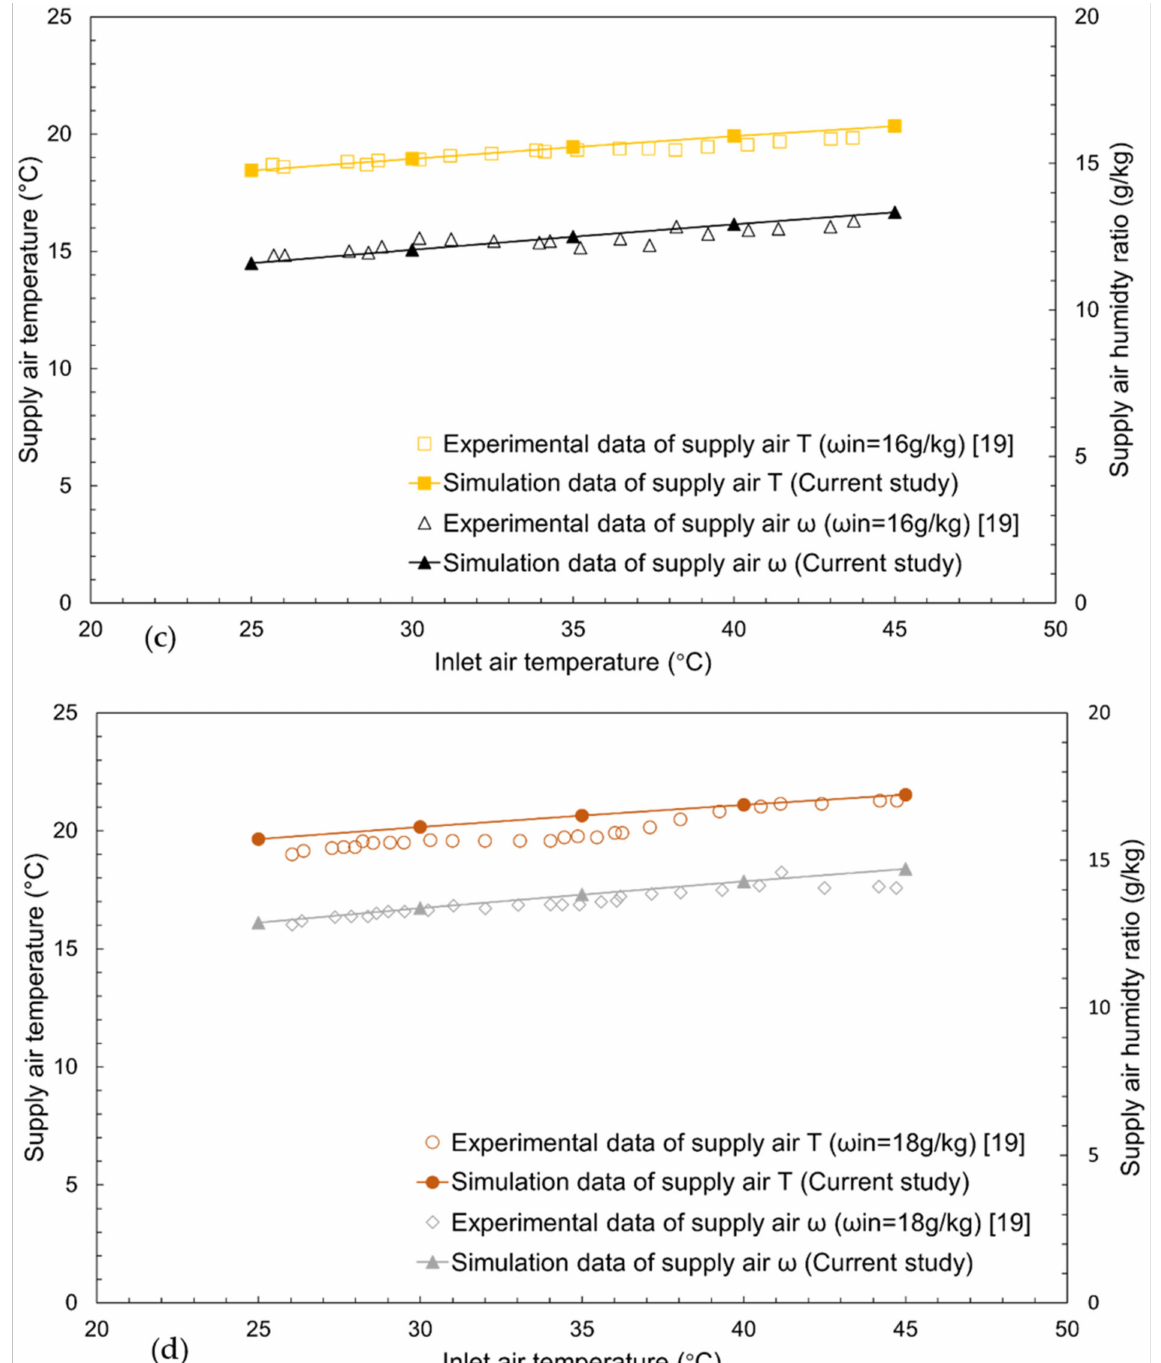
Figure 3. SDM model verification with experimental data from Ref. [18] at four different inlet air humidity levels: ( a ) ω in = 12 g/kg; ( b ) ω in = 14 g/kg; ( c ) ω in = 16 g/kg; ( d ) ω in = 18